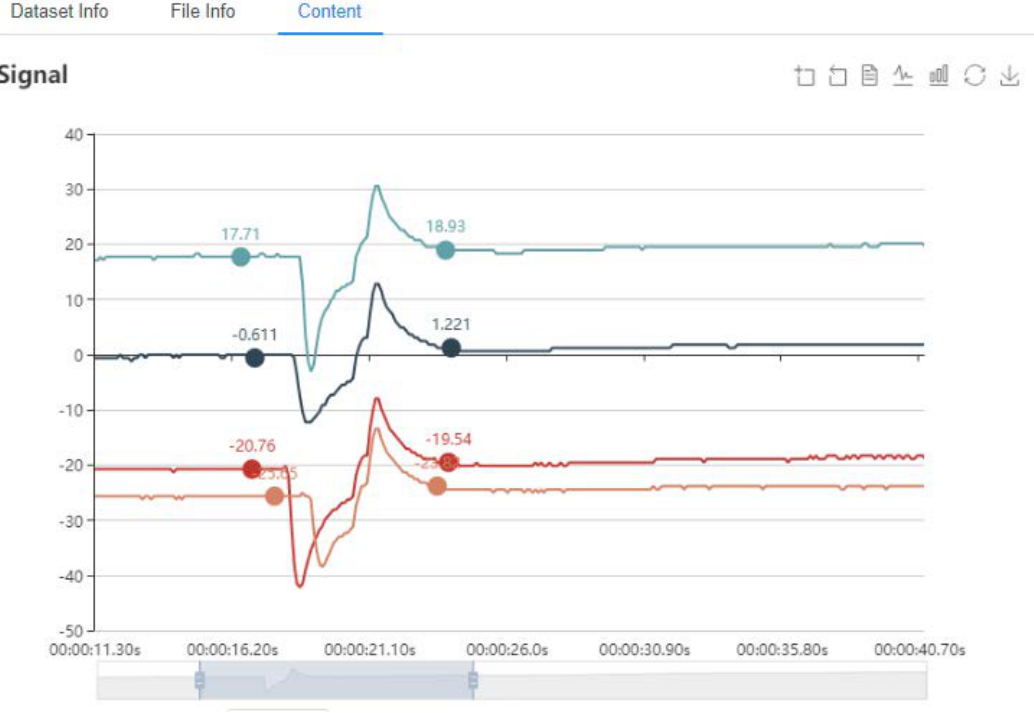
Figure 14. The examples of observed waveform for classification.